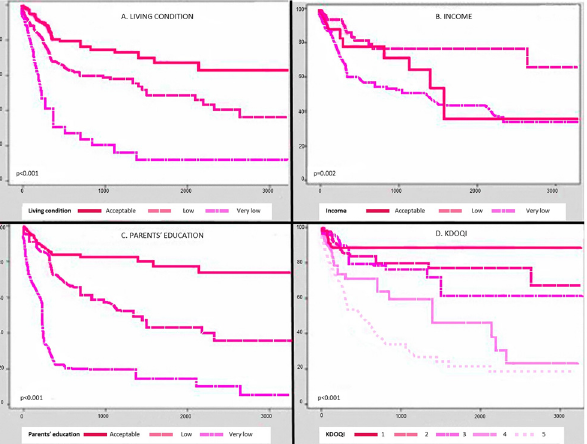
Fig 1. Survival curves. Owing to the great variability of the characteristics of the cohort (from age, to duration of disease, to disease stage at entry, to the different robustness of the socioeconomic markers), only a fully adjusted multivariable analysis of the whole cohort could provide a synthetic view of the determinants of the combined outcome end-point of the cohort as shown in Table 5.